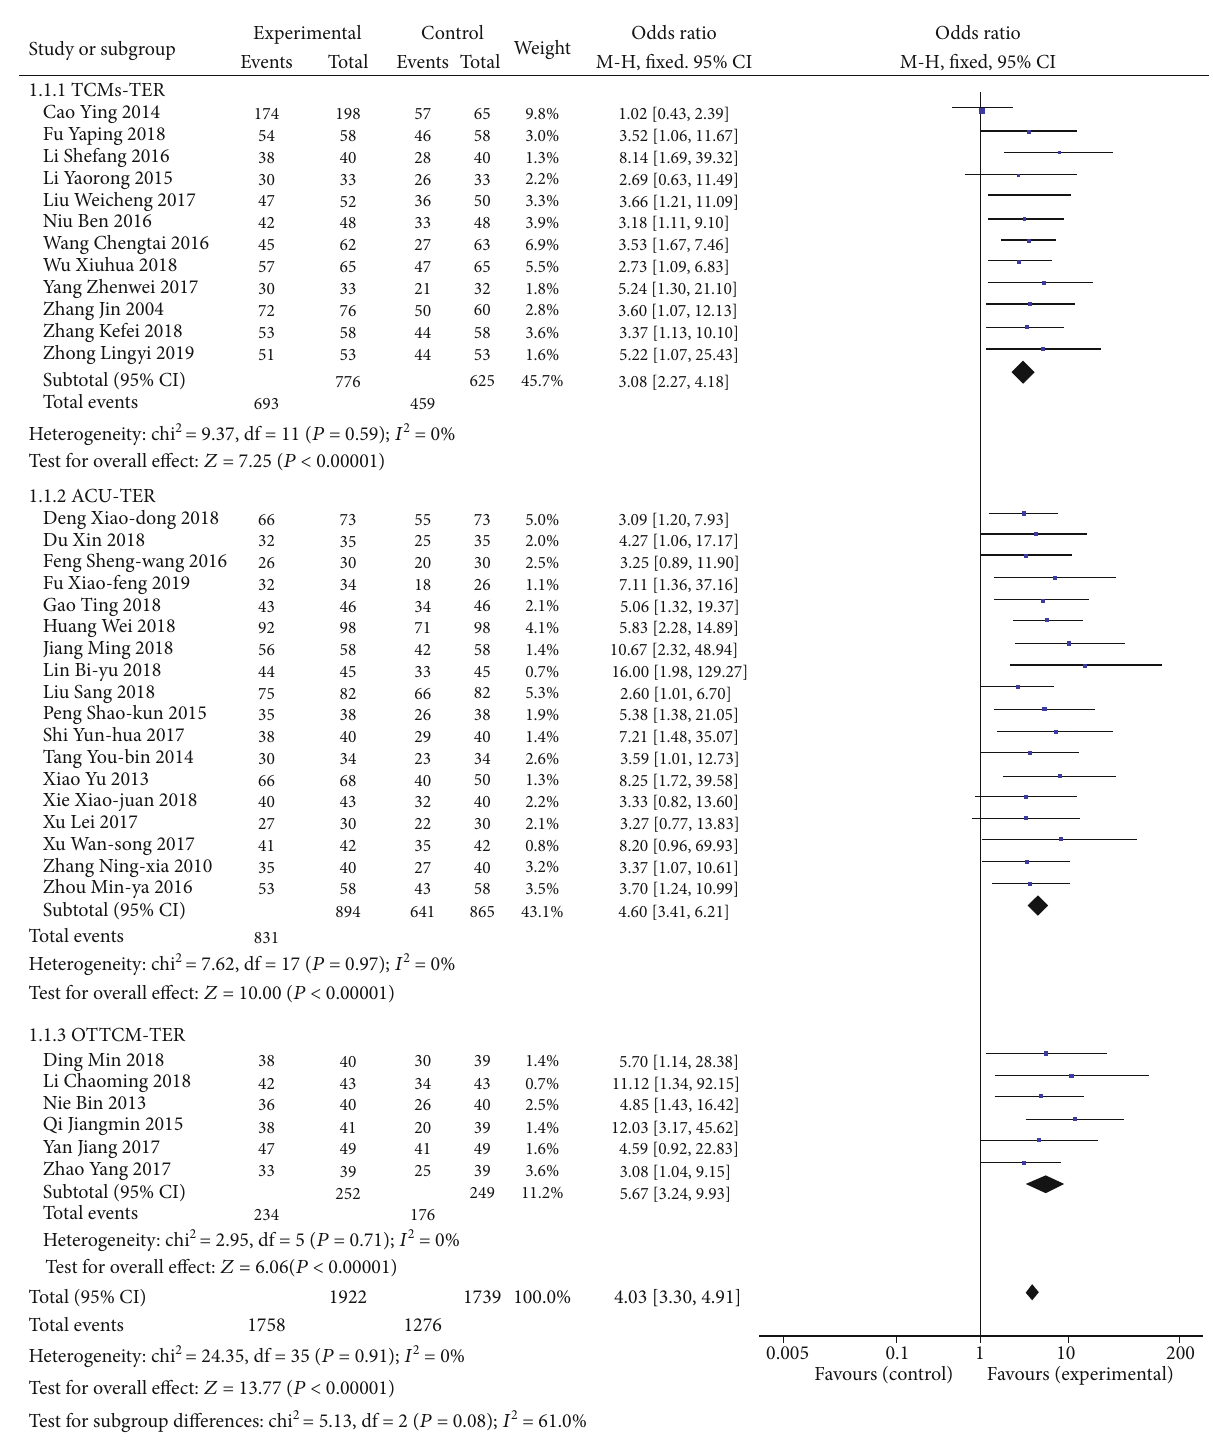
Figure 4: Forest plot of TER treated with TCMs, ACU, and OTTCM